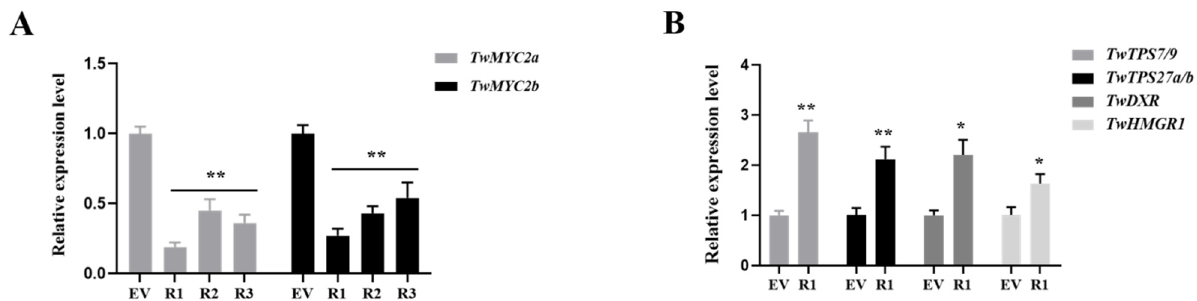
Figure 4. Relative expressions of TwMYC2a / b ( A ) and several key triptolide biosynthesis genes ( B ) in the RNAi transgenic and control hairy roots lines. Elongation factor 1 α (EF1 α ) was used as the internal standard for gene expression normalization. All data presented here are means ± SD of three biological replicates. Statistical significance was determined by Student’s t -test (* p < 0.05; ** p < 0.01). These assays were repeated two times with similar results.